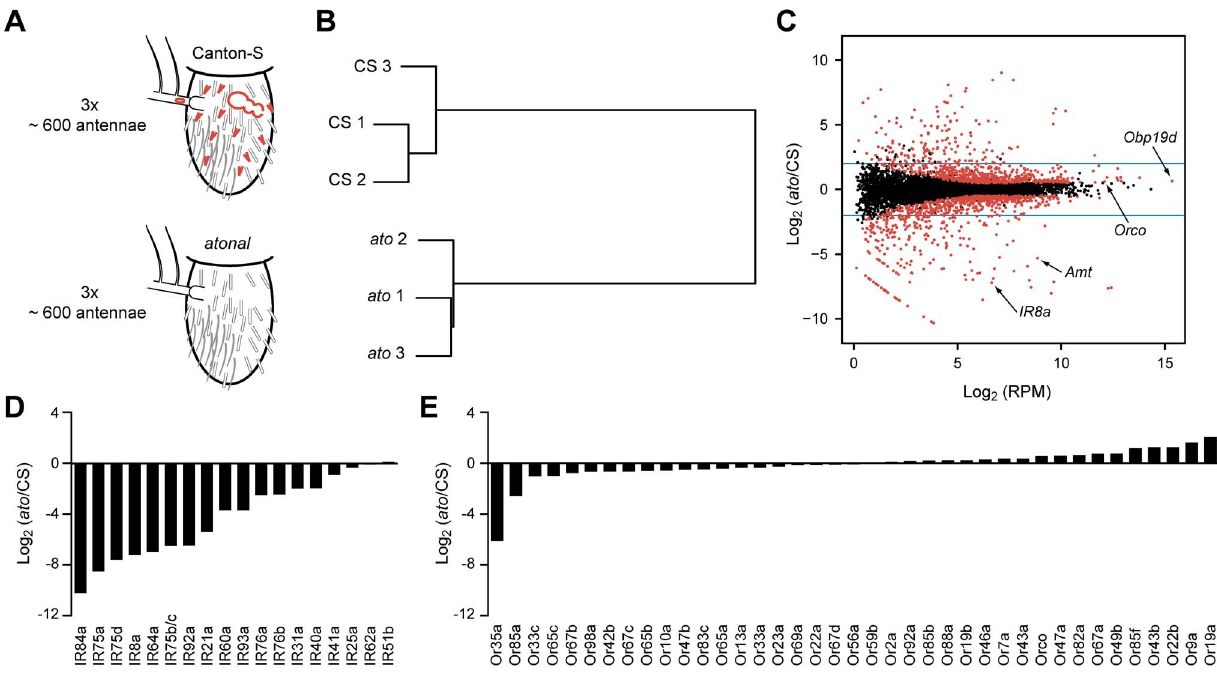
Figure 2. Transcriptome profiling identifies genes differentially expressed in CS and ato third antennal segments. (A) Schematic of the RNA-Seq screen in which three independent biological samples of third antennal segments from both CS and ato flies were collected. ato flies selectively lack coeloconic sensilla (small red hairs), aristal neurons (red oval in the arista, which extends to the left), and the multi-chambered sacculus (red bubble-like structure), which contains coeloconic sensilla. (B) Hierarchical cluster analysis of each sample based on their gene expression, showing that the expression patterns cluster by genotype. (C) Each of the antennal-expressed genes (dots) is plotted based on its average expression level in RPM and the log 2 of the expression ratio between ato and CS flies. Most genes cluster around 0, indicating no change in expression. Red dots indicate differentially expressed genes (FDR , 0.01), and the blue horizontal lines indicate a four-fold change level. Several genes of interest are indicated. The diagonal ‘‘line’’ of red dots in the bottom left consists of genes with no expression in ato (see Materials and Methods). (D) Nearly all of the IR genes are greatly reduced in ato antennae, consistent with their known localization to coeloconic sensilla. (E) In contrast, most of the Or genes expressed in CS antennae show little if any reduction in ato. We note that the fold-change values are approximate and are especially difficult to assess for genes that are expressed at extremely low levels in ato . (Figure S1). See Methods for further details.